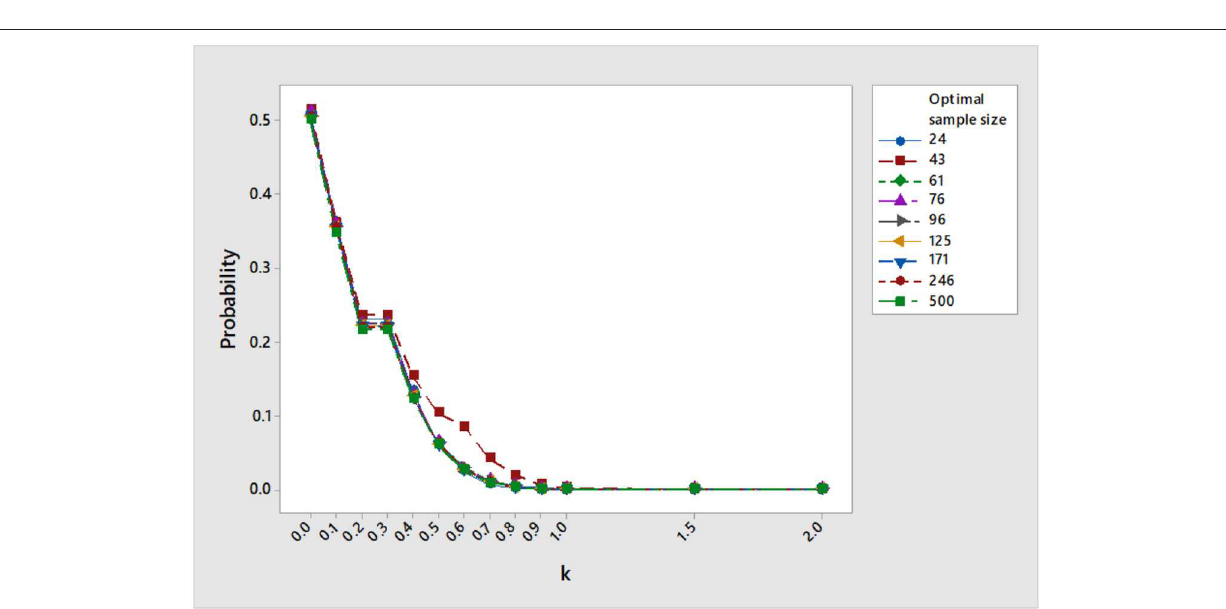
10, σ 5, η 2, γ 0.5, and α 0.05 and β 0.05. = = = = = =